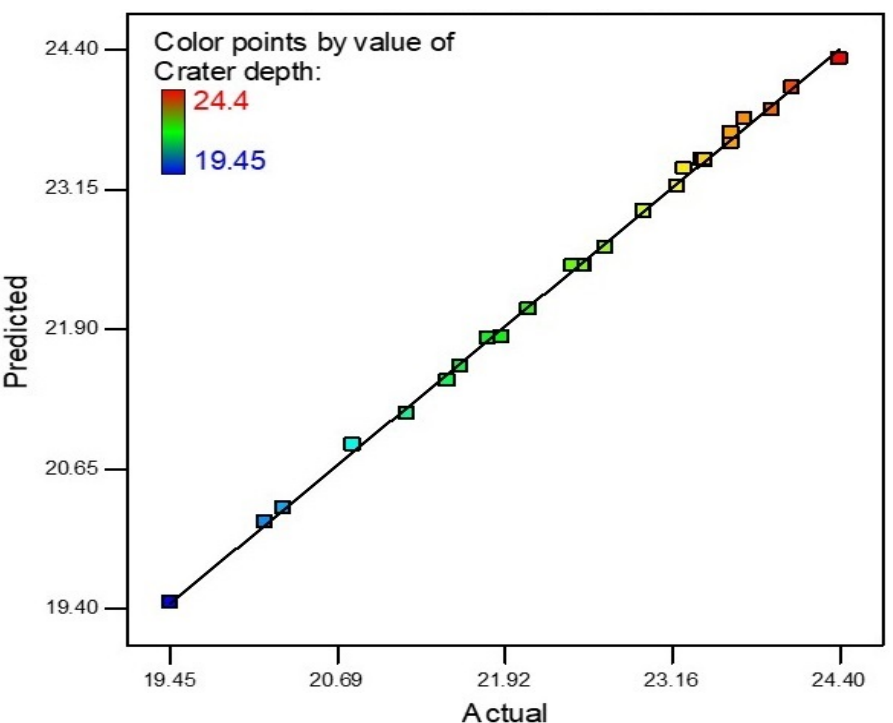
Figure 11. Crater depth predicted vs. actual values.